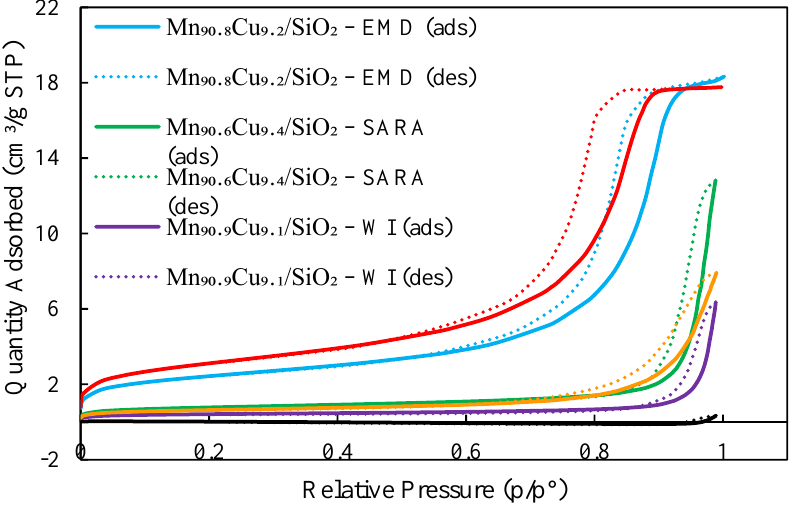
Figure 3. Nitrogen adsorption(ads)/desorption(des) isotherms of the Mn–Cu oxide catalysts sup- ported by the silica gel powder.